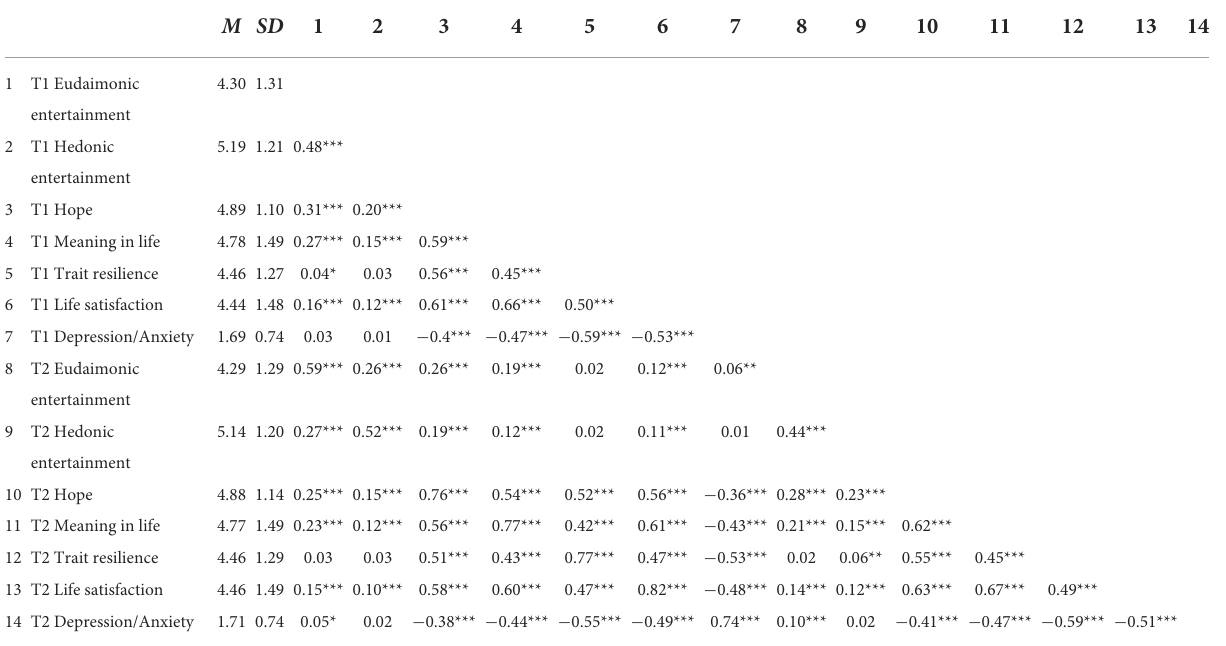
TABLE 1 Means, standard deviations, and zero order correlations of all constructs at T1 and